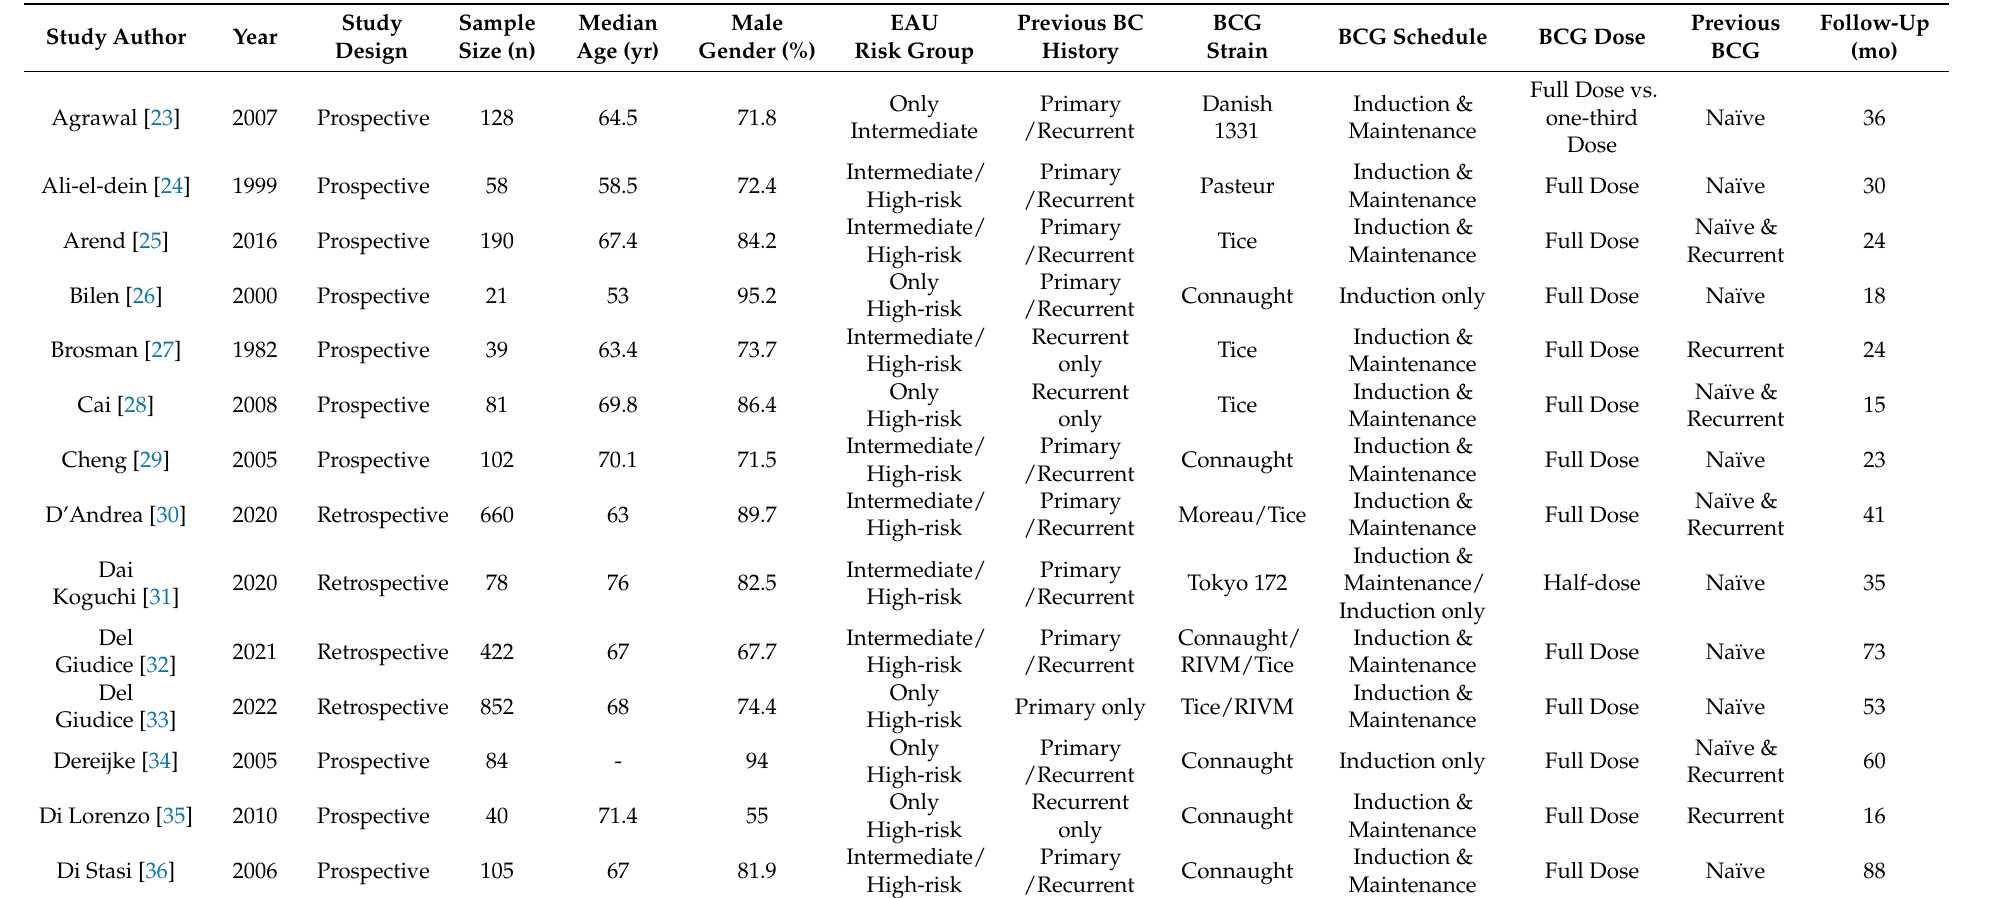
Table 1. Clinical, demographic, and BCG-related features of the studies and patients enrolled in the systematic review and meta-analysis. MIBC: muscle-invasive bladder cancer; EAU: European Association of Urology; BCG: Bacillus Calmette–Gu é rin; yr: Year; mo: